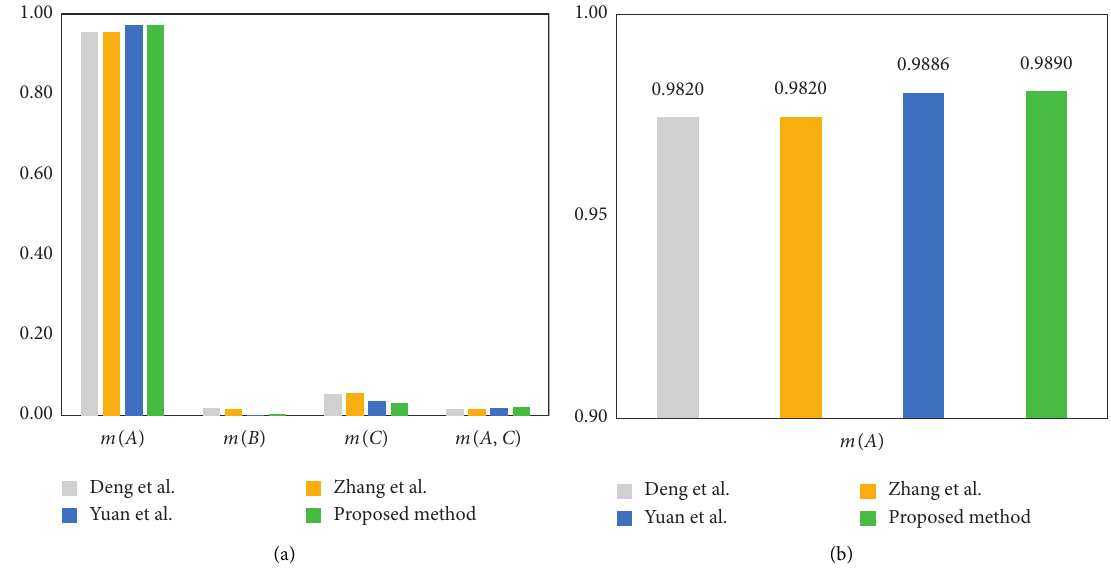
Figure 2: Comparison of fusion results generated by different methods in experiment: (a) fusion result for different objectives; (b) fusion result for target